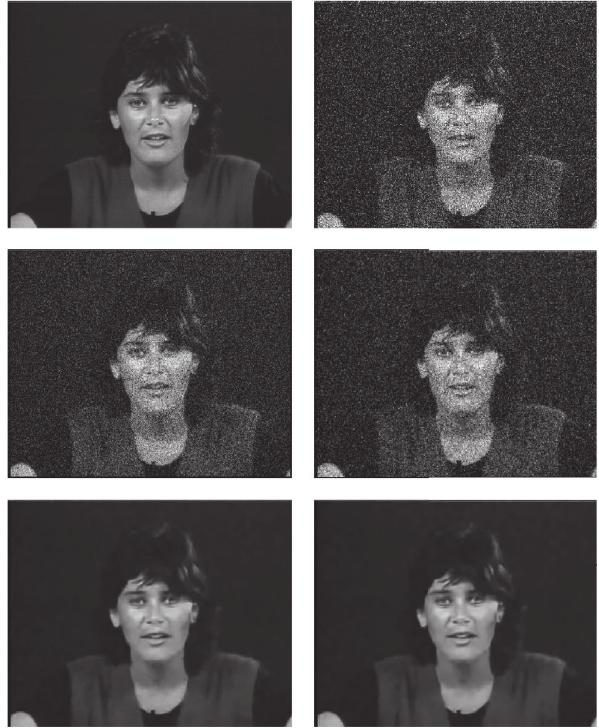
Figure 1: Visual comparison of different algorithms for frame 5 of the Miss America sequence. From left to right and from top to bottom: original frame, noisy frame ( 𝜎 𝑛 = 40 ), result of [18] algorithm, result of [19] algorithm, result of [13] algorithm, and result of the proposed